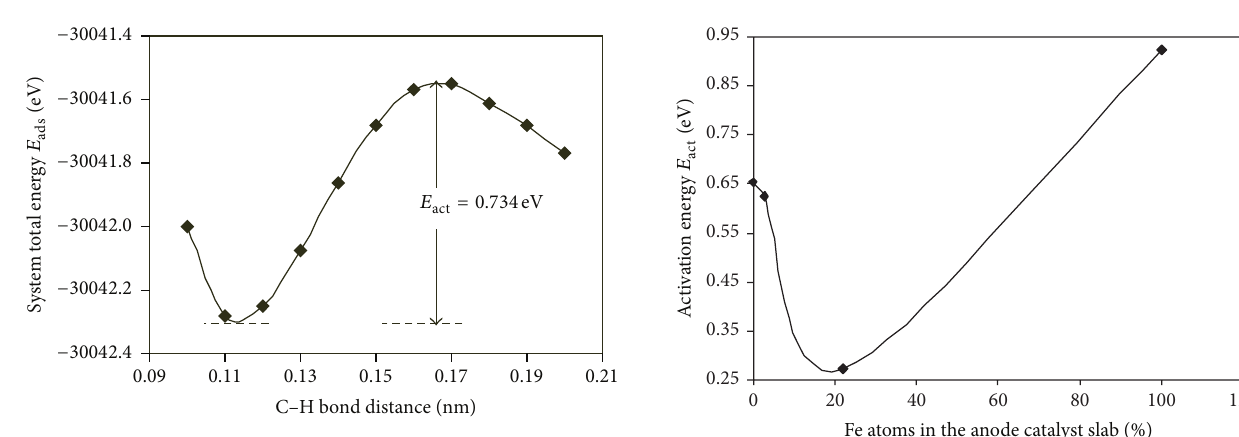
(eV), for water act